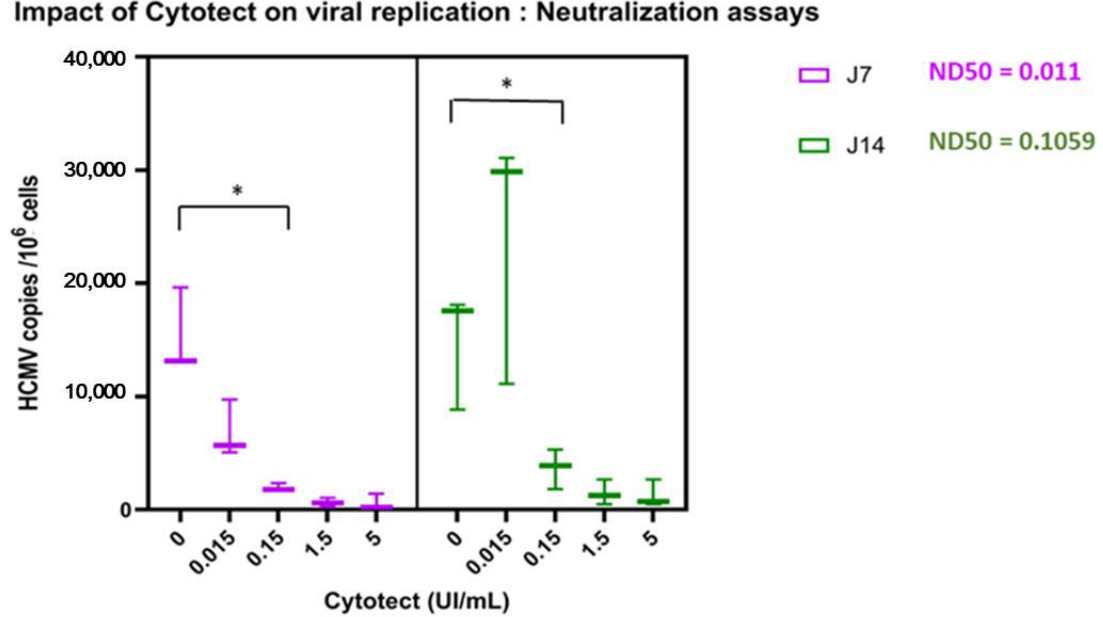
Figure 4. Neutralization assay: ex vivo viral load in villi at 7 and 14 days post-infection . The results were compiled from three placentae. The statistical analyses were carried out using GraphPad Prism with a two-way ANOVA (GraphPad Software, San Diego, CA, USA). *: p < 0.05.